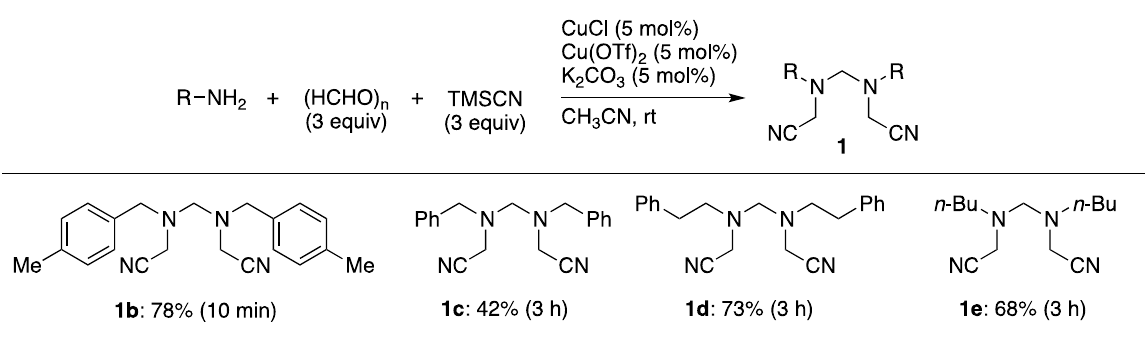
Table 2. Selective synthesis of bis(cyanomethyl)methylenediamines 1 with paraformaldehyde a